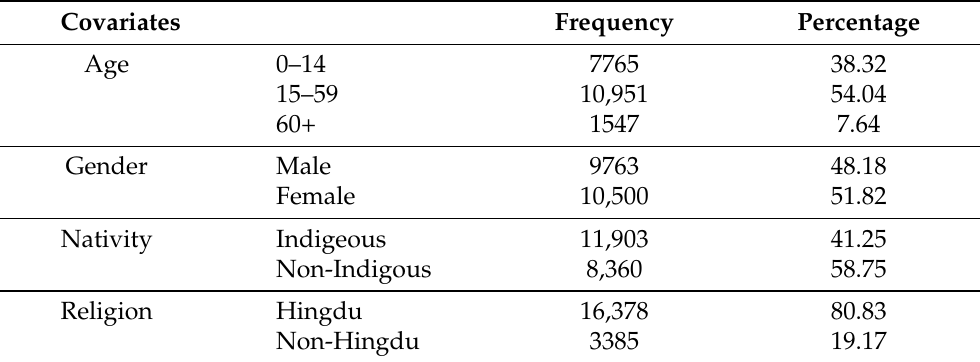
Table 2. The descriptives of 4